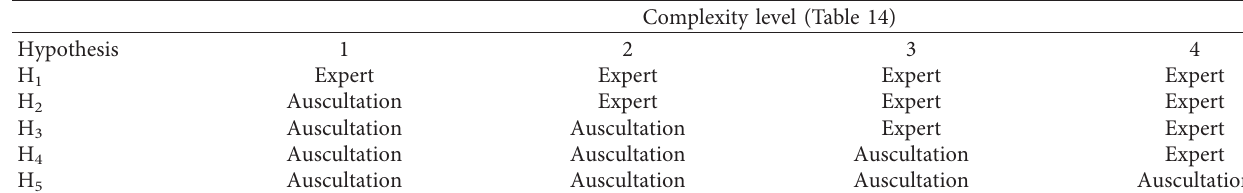
Table 17: Hypothesis on supplying methods.